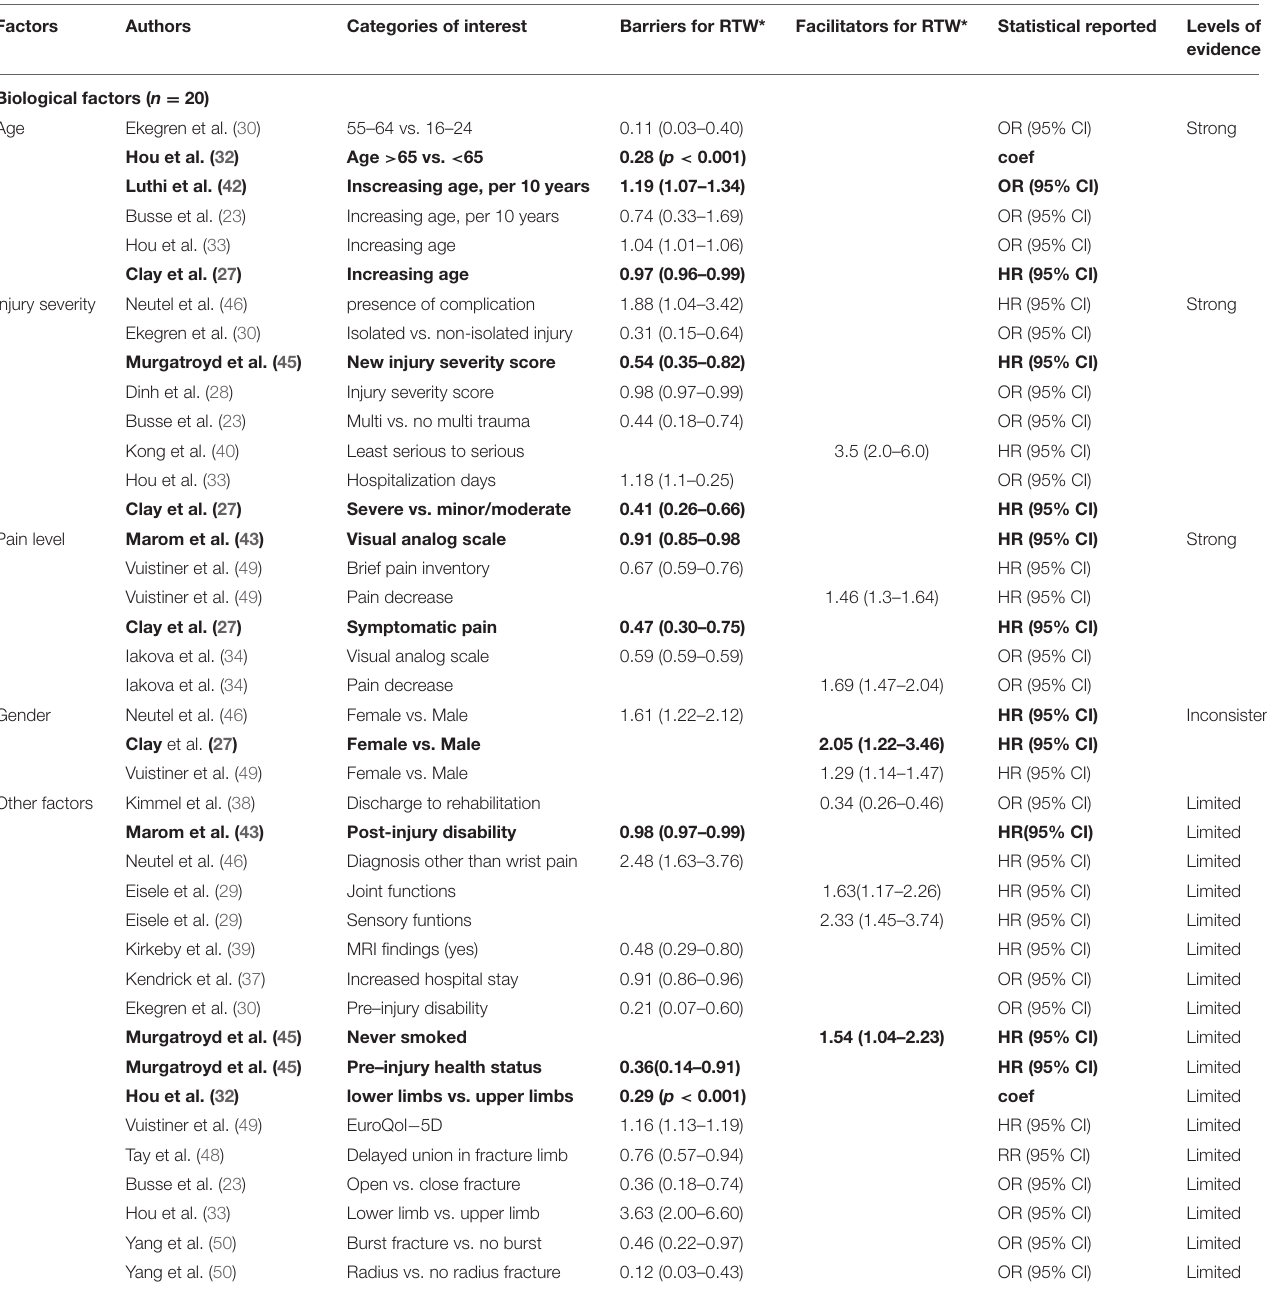
TABLE 4A | Barriers and facilitators for RTW in the late phase ( > 6 months) postinjury (part